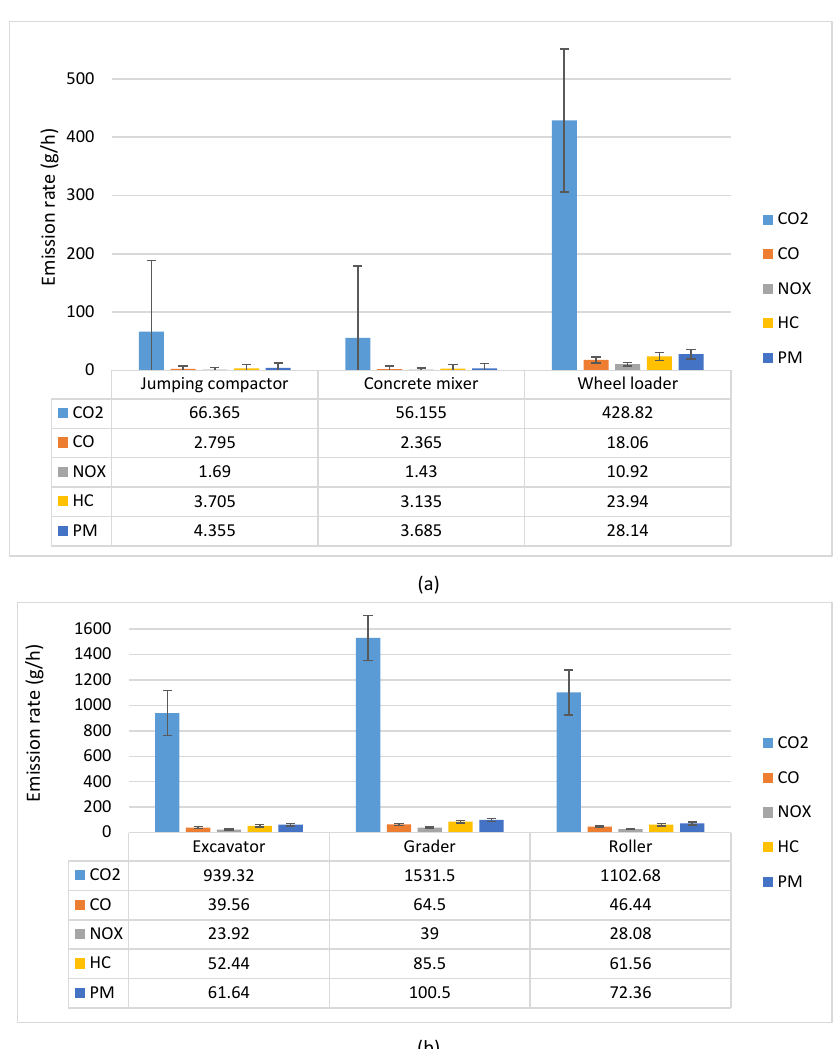
Fig. 3: Total emissions per hour for the sampled equipment: (a) and b)